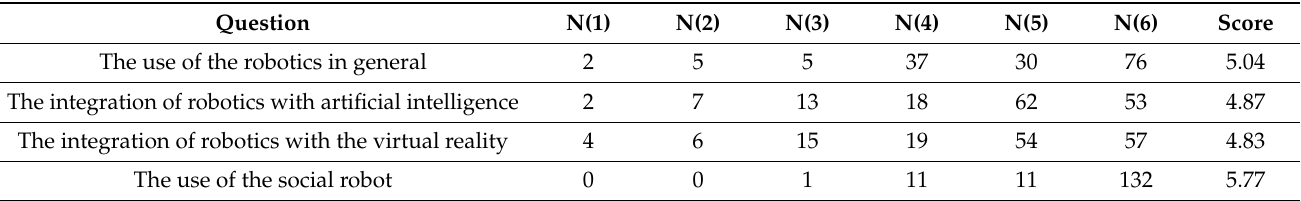
Table 5. Output from the Likert question “Regarding the organizational aspects, do you think that ethical issues can hinder”.